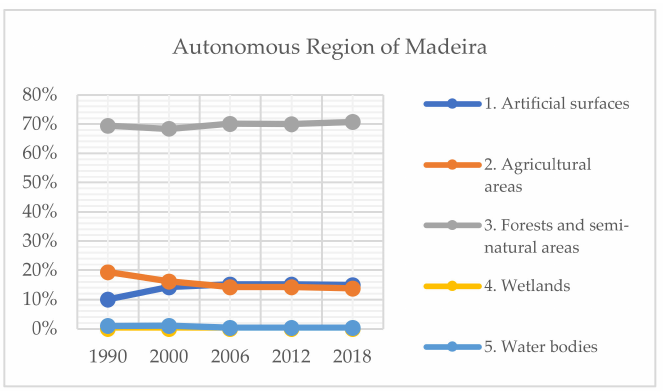
Figure 9. Percentage of land-uses according to level 1 of CLC nomenclature in the Autonomous Region of Madeira.